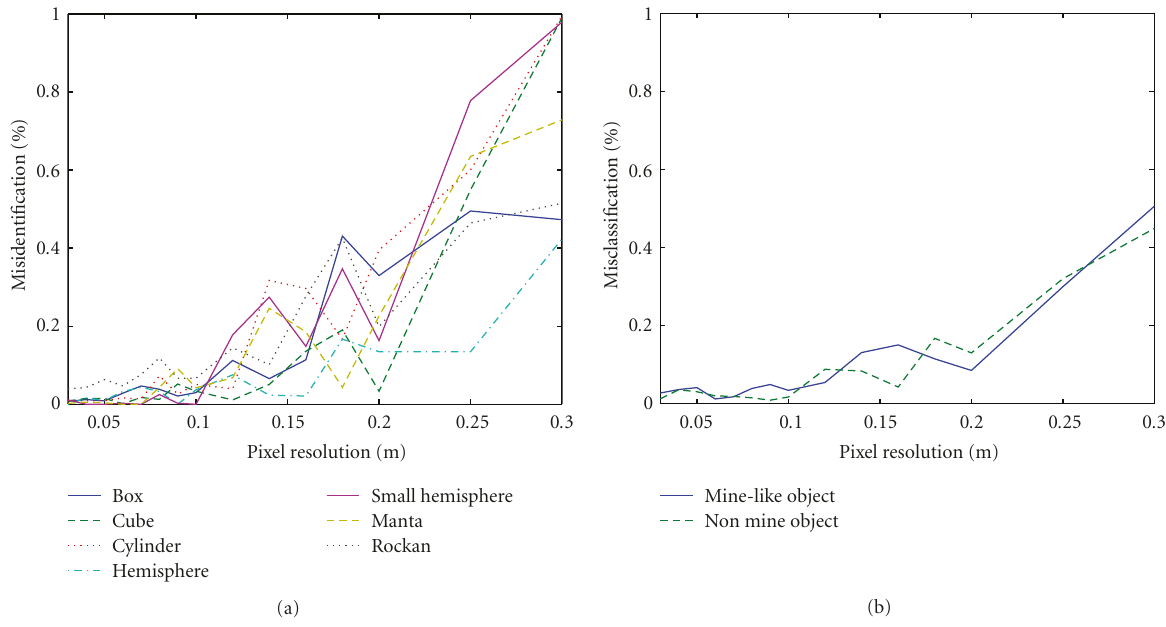
Figure 13: (a) Misidentification of the seven targets as a function of the pixel resolution. (b) Misclassification of the target as function of the pixel